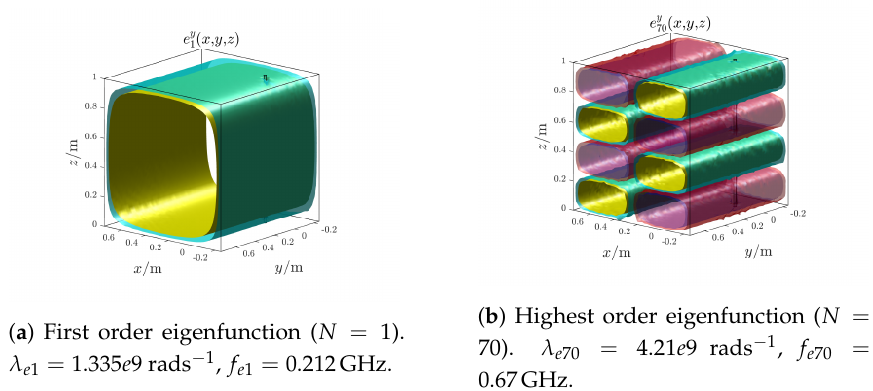
Figure 11. Test case 1. First and highest order electric field eigenfunctions.